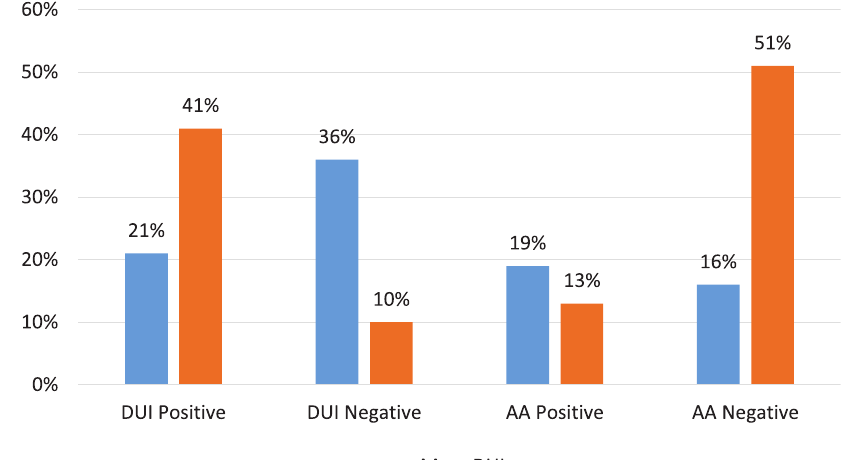
Figure 1. Politically affiliated individuals and their perception of false political information. Notes: AA voters—DUI posi‐ tive = 21%, DUI negative = 36%, AA positive = 19%, AA negative = 16%; DUI voters—DUI positive = 41%, DUI negative = 10%, AA positive = 13%, AA negative = 51%.